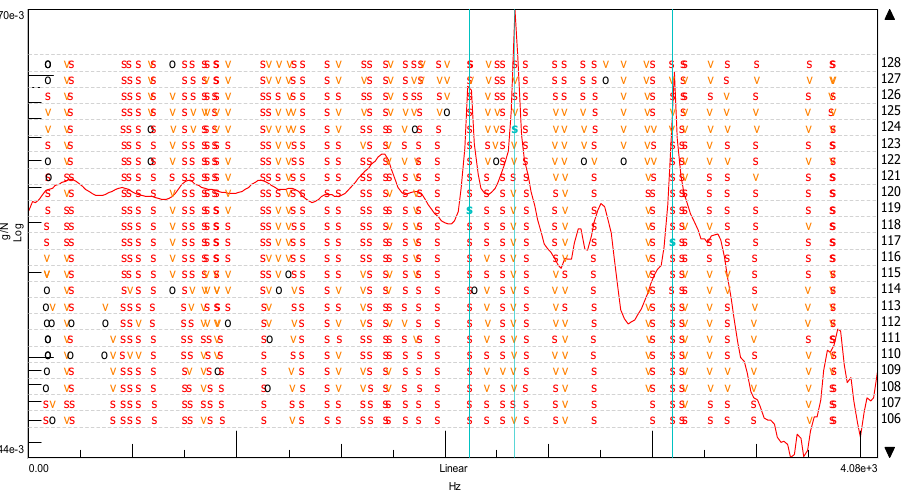
Figure 21. Spectral function of the FRF transition created with the use of the SUM indicator for the ordinary concrete cube with the addition of fly ash from sewage sludge.